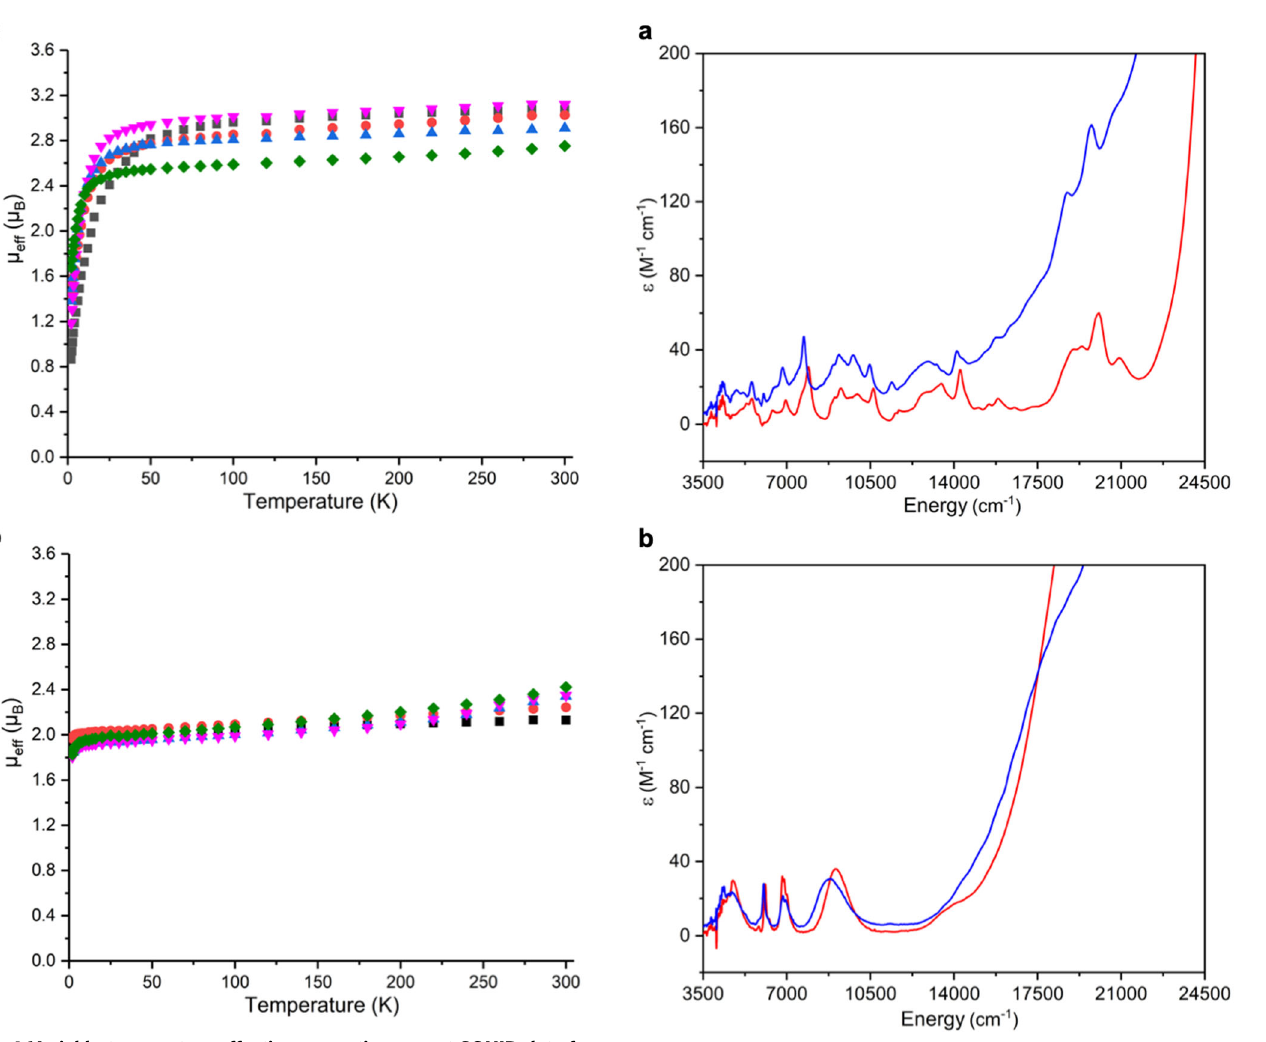
Fig. 5 UV/Vis/NIR spectroscopic data for uranium(IV)-imido (3Li/Cs) and uranium(V)-nitrides (5Li/Cs) complexes. a ε (M − 1 cm − 1 ) vs energy (cm − 1 ) of 3Li (red trace) and 3Cs (blue trace) in toluene. b ε (M − 1 cm − 1 ) vs energy (cm − 1 ) of 5Li (red trace) and 5Cs (blue trace) in